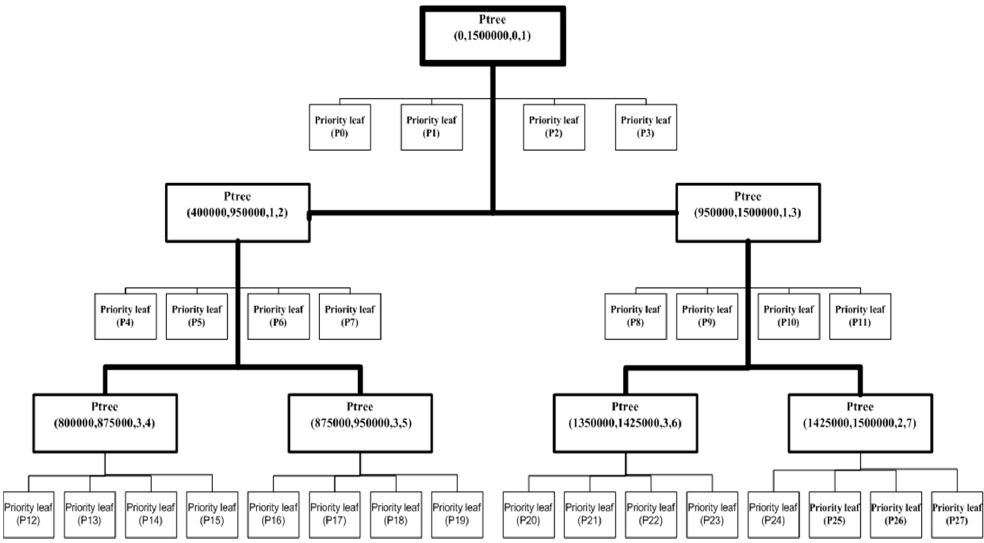
Figure 2. PR-Tree structure for a file with a 1.5 M rectangle.